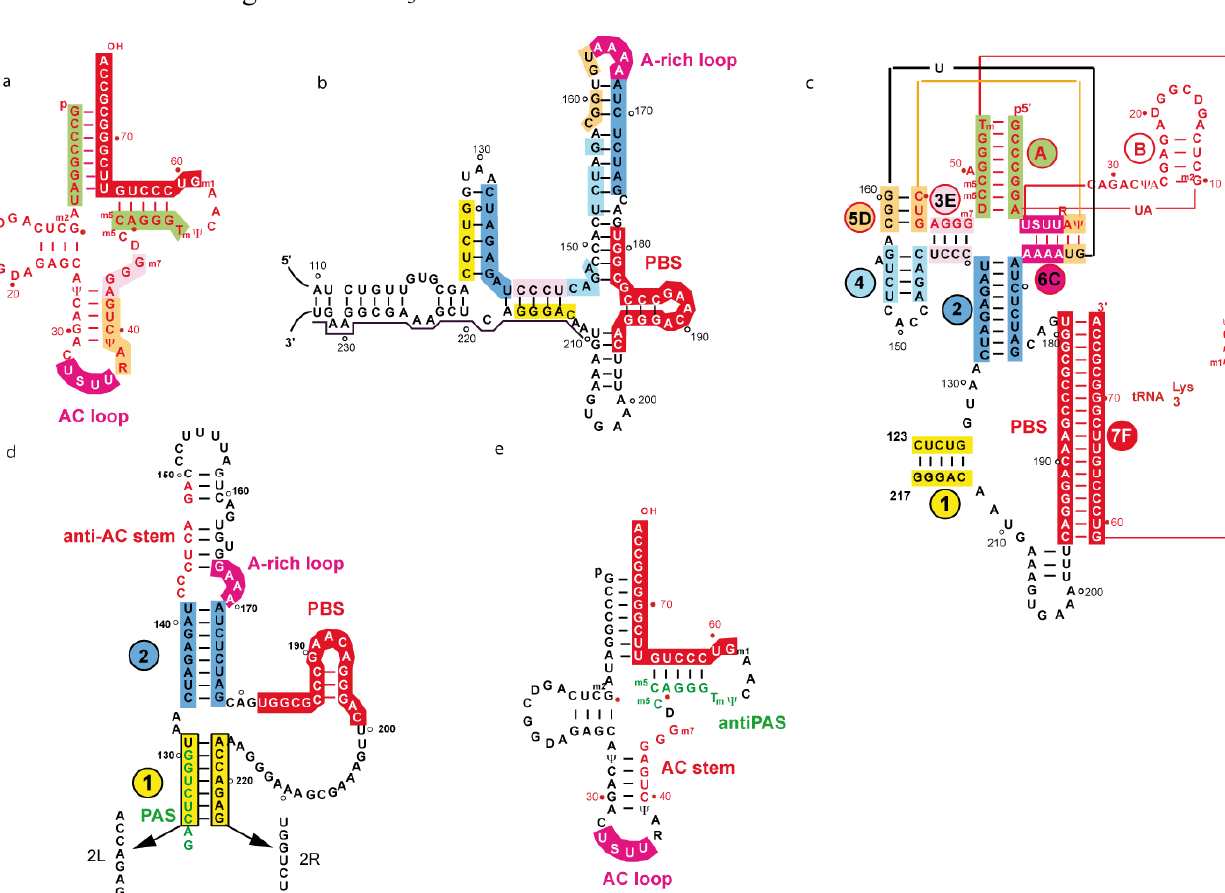
Figure 4. Secondary structure of the RNA partners of the HIV-1 initiation complex of reverse transcription and of the binary primer/template complexes, in the case of the HIV-1 MAL (representative of a subtype A PBS domain) and subtype B isolates. The regions undergoing intra- or intermolecular rearrangements upon formation of the primer/template complex are highlighted in various colours. Boxes or sequences of the same color represent areas that are base-paired in the binary complex. (a) The human tRNA 3Lys . (b) The PBS sub-domain in the free form of the HIV-1 MAL vRNA. (c) The HIV-1 MAL vRNA/tRNA 3Lys complex. (d) The PBS sub-domain in the free form of the HIV-1 NL-4.3 (subtype B) isolate. The PAS and mutations 2L and 2R are indicated. (e) Localization of the anti-PAS region of tRNA 3Lys